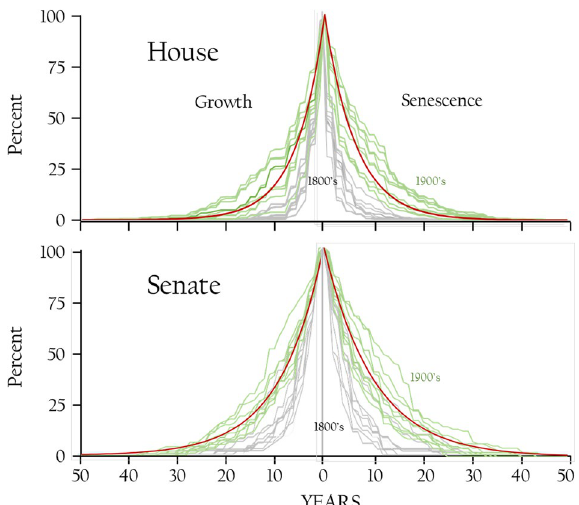
Fig. 8 Distributions of years served and years remaining in the U.S. House and Senate in 10-year intervals from 1800 through 1980. The red exponential curves were generated using the inverse of the mean-of-means for the nine distributions shown in green for the Congresses during the twentieth century, 1900 to 1980. Rate parameter values for the growth and senescence exponents of the House were 0.141 and 0.136, respectively, and for the Senate were 0.111 and 0.101, respectively